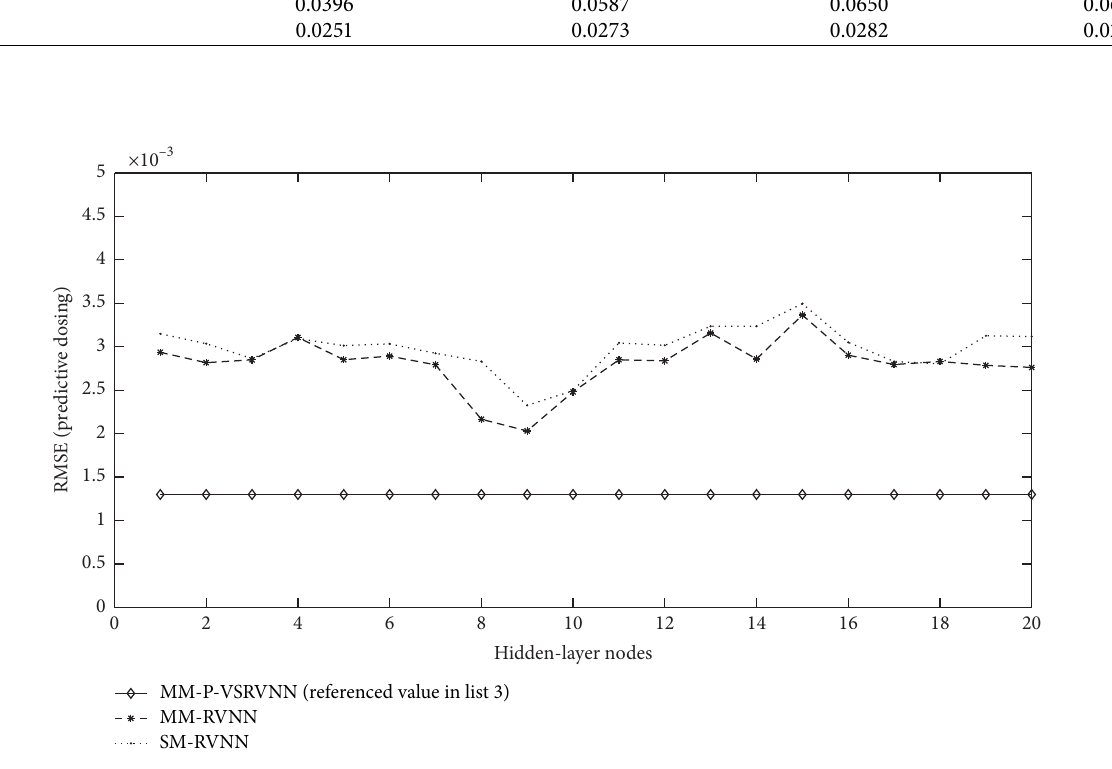
Figure 10: RMSE for predicted dosage by different algorithms when hidden-layer nodes varied from 1 to